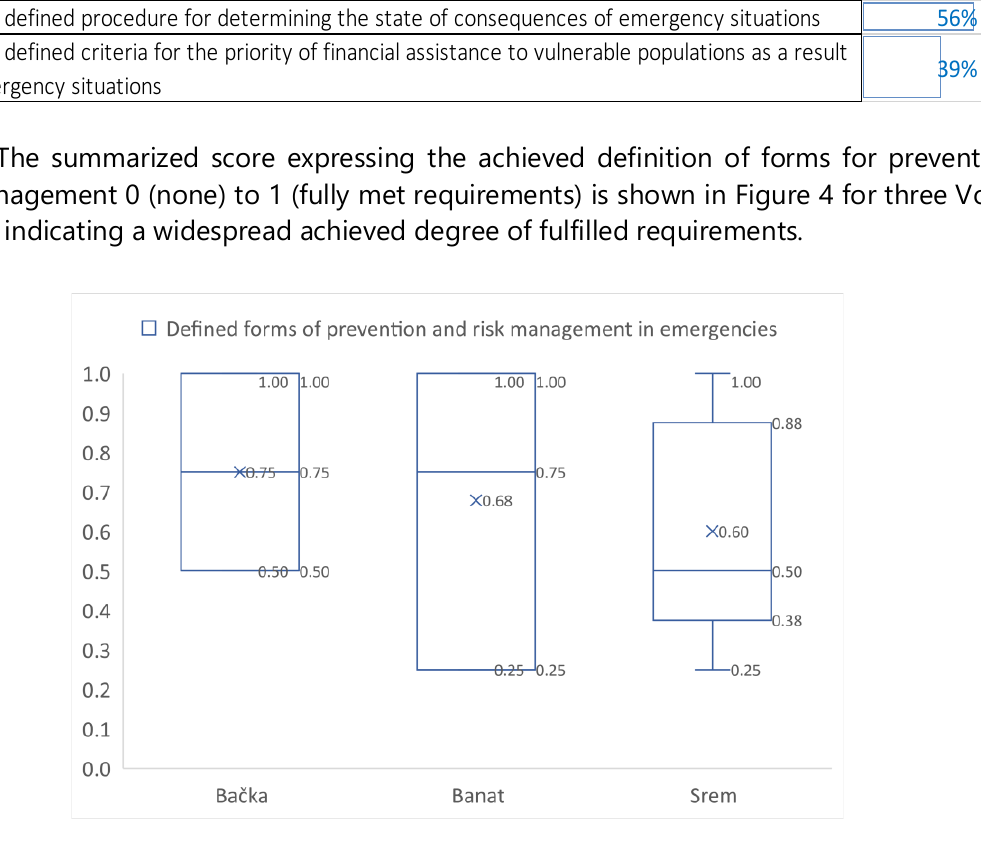
Defined forms of prevention and risk management in emergencies